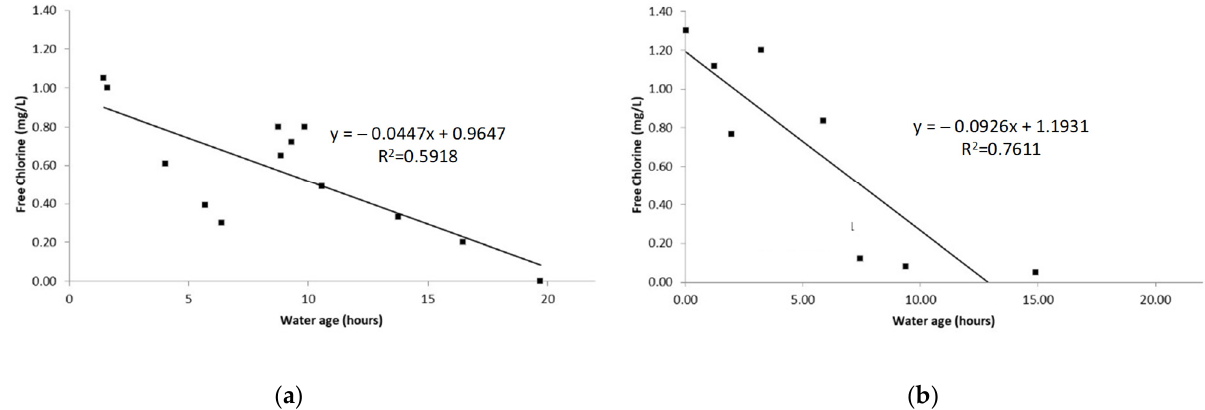
Figure 6. Mean water age and chlorine concentrations at the sampling nodes in Case Study 1 in ( a ) winter and ( b ) summer.